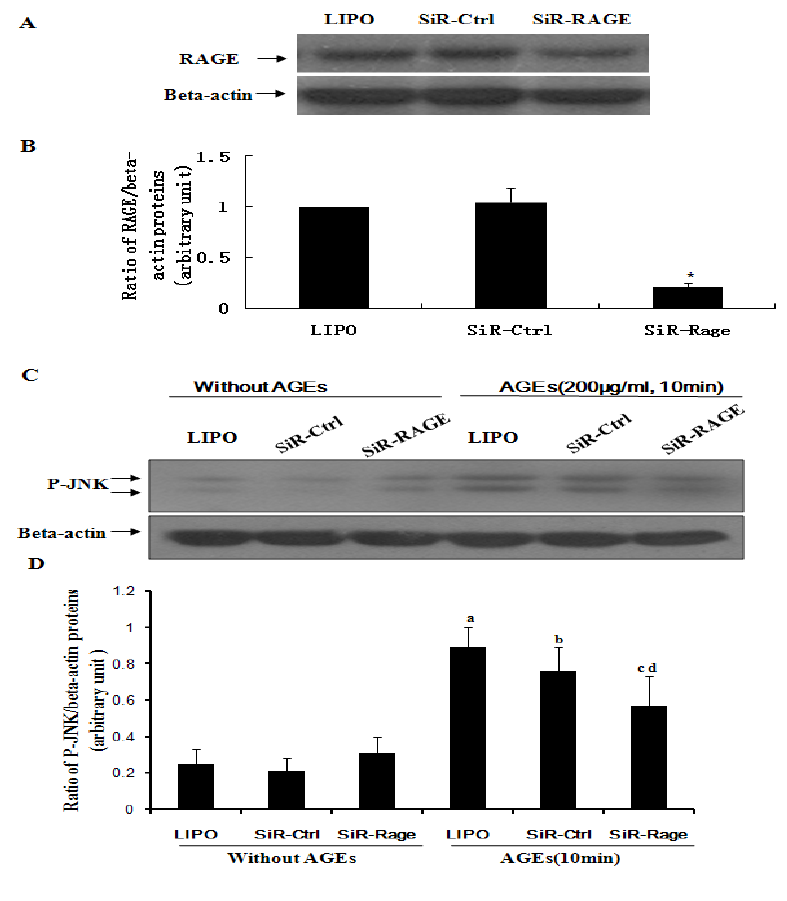
Figure 4. Knockdown of the receptor for AGE (RAGE) inhibits AGE-induced activation of JNK in ECV304 cells. ( A ) Western blotting shows the effect of siRNA-RAGE on expression of RAGE; ( C ) Western blotting shows that knockdown of RAGE via siRNA-RAGE results in significant inhibition of JNK activation induced by AGEs; ( B , D ) The statistical results of (A) and (C) show ( * ) siRNA-RAGE (SIR-Rage) vs. siRNA control (Sir-Ctrl); AGEs vs. ( a ) Lipofectamine 2000 control (Lipo); ( b ) Non-targeting siRNA control (Sir-Ctrl); and ( c , d ) siRNA-RAGE (SIR-Rage) or Sir-Ctrl. All results gave p < 0.05. Results are from three independent experiments; β -actin was used as an internal